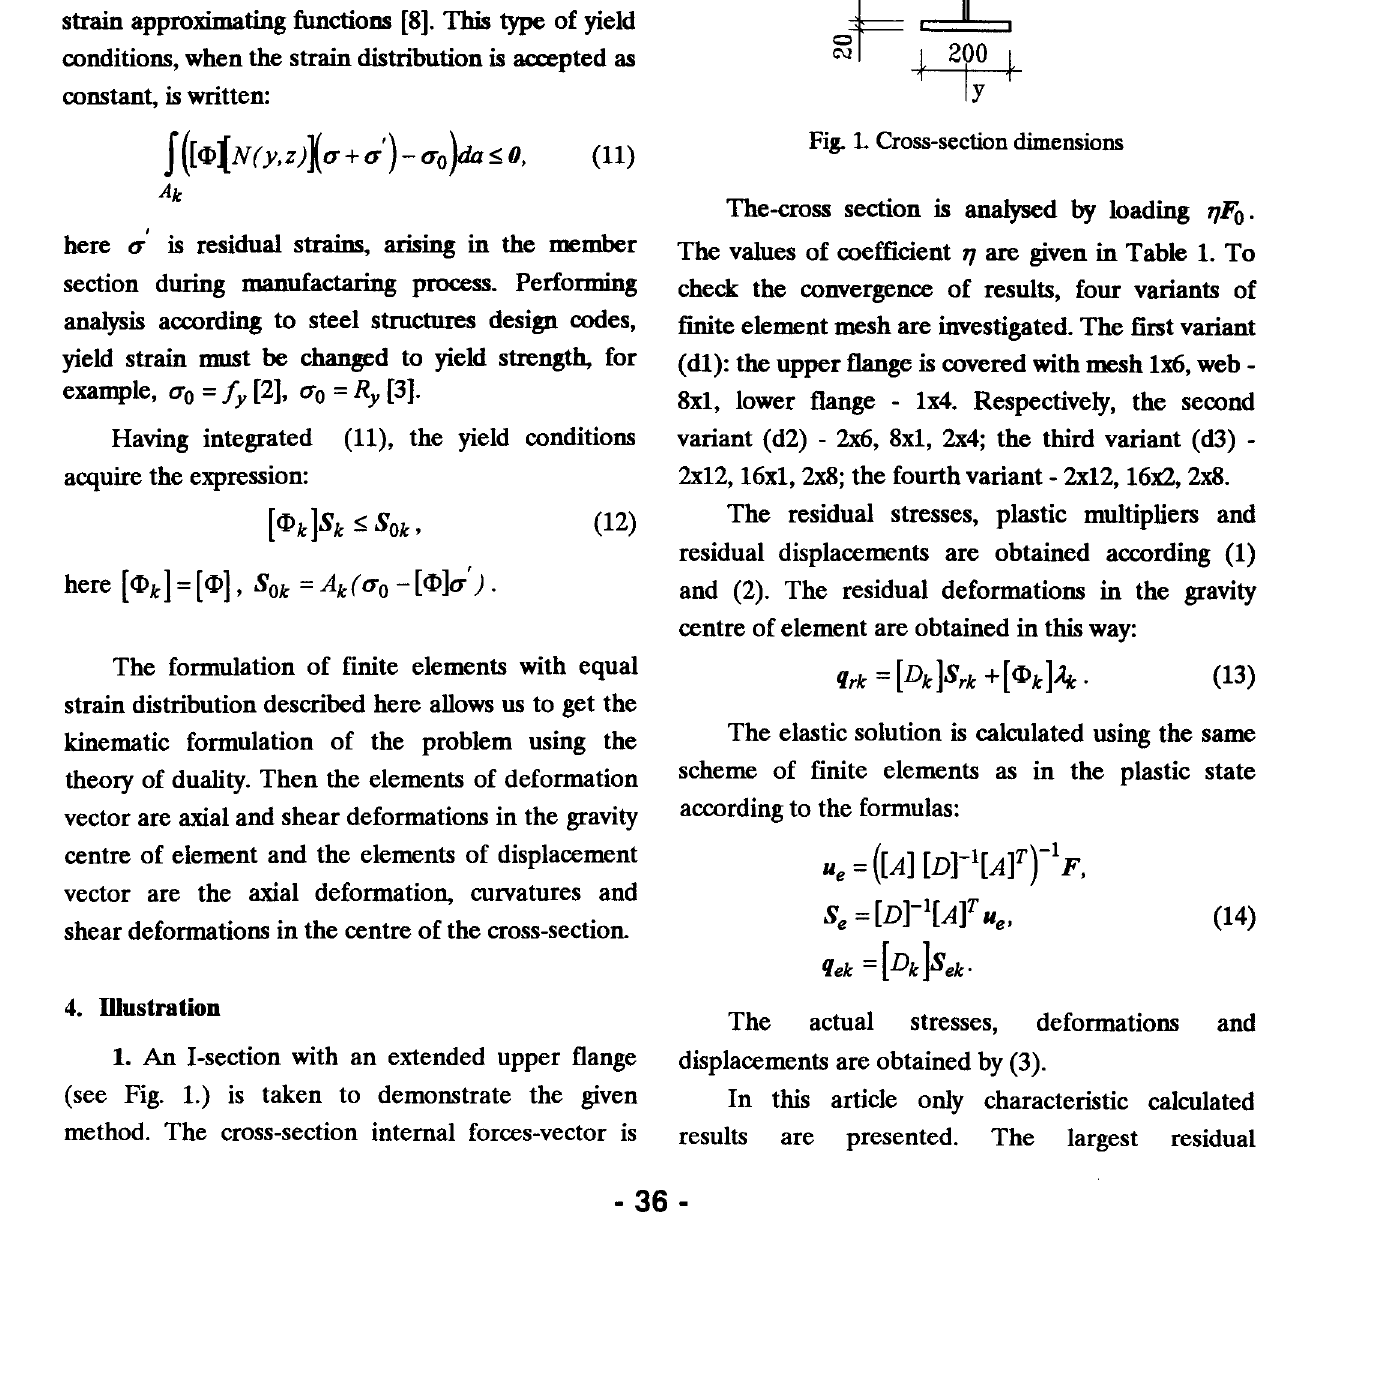
Fig. 1. Cross-section dimensions The-cross section is analysed by loading 17F